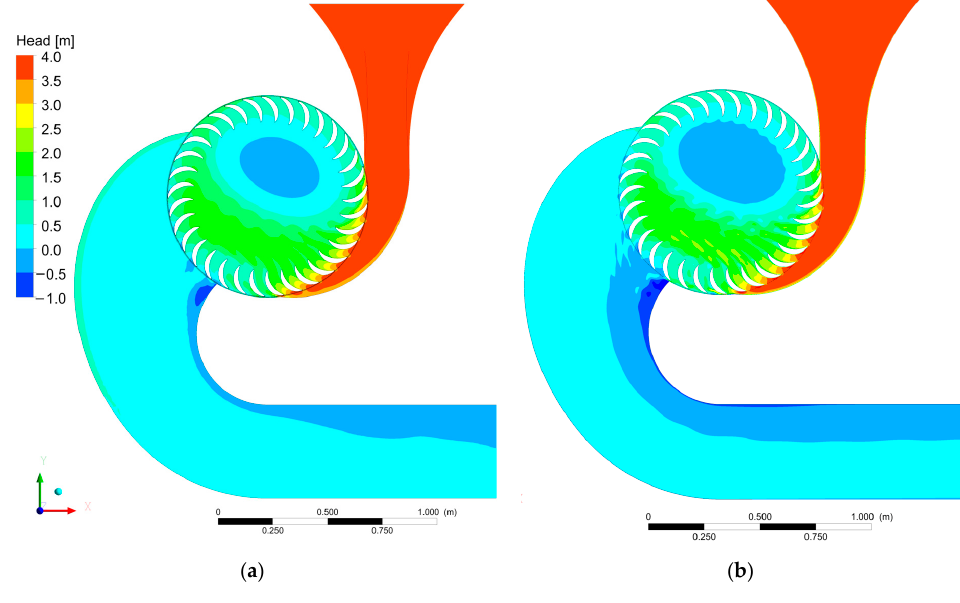
Figure 14. T.E.L. of UL-PRS: ( a ) 3D and ( b ) 2D. See in Figures 15 and 16 3D views of the 3D